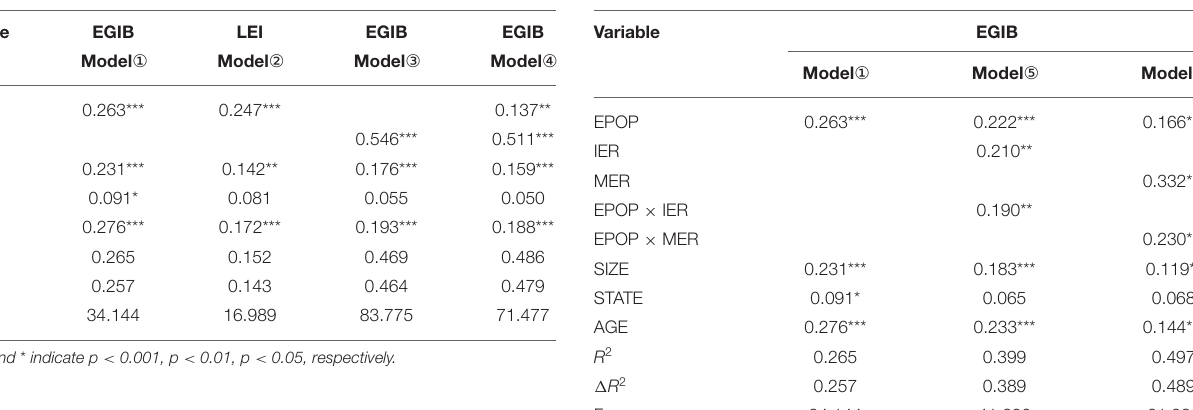
TABLE 3 | Results of main and mediating effect test. TABLE 4 | Results of moderating effect test.